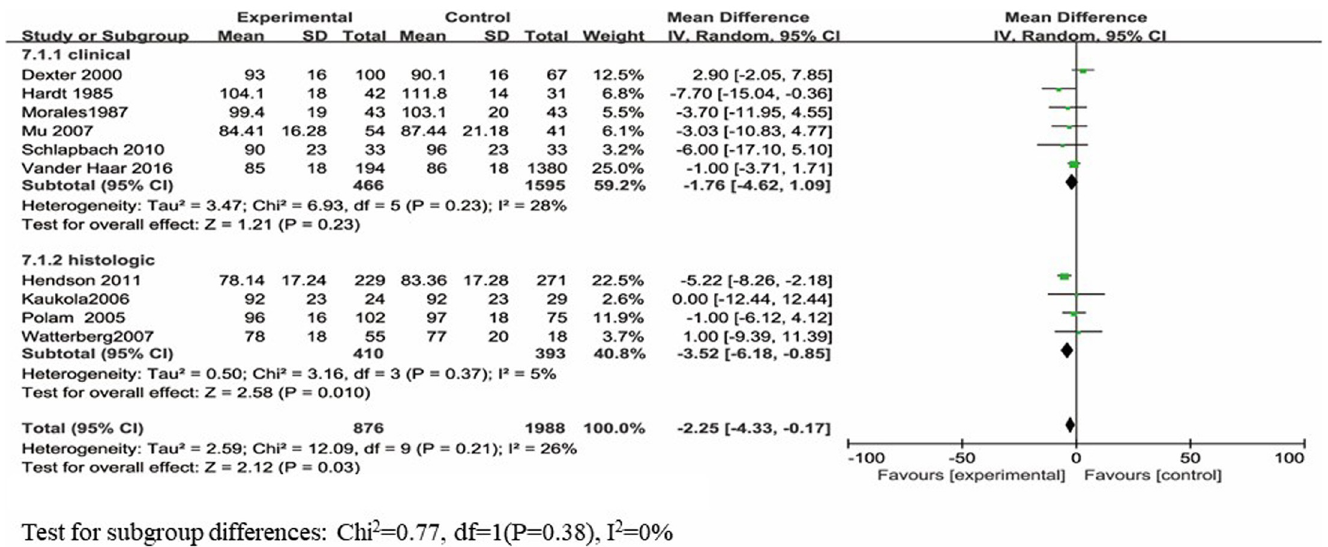
Fig 2. Forest plot of pooled analysis of maternal chorioamnionitis and the MDI in offspring.